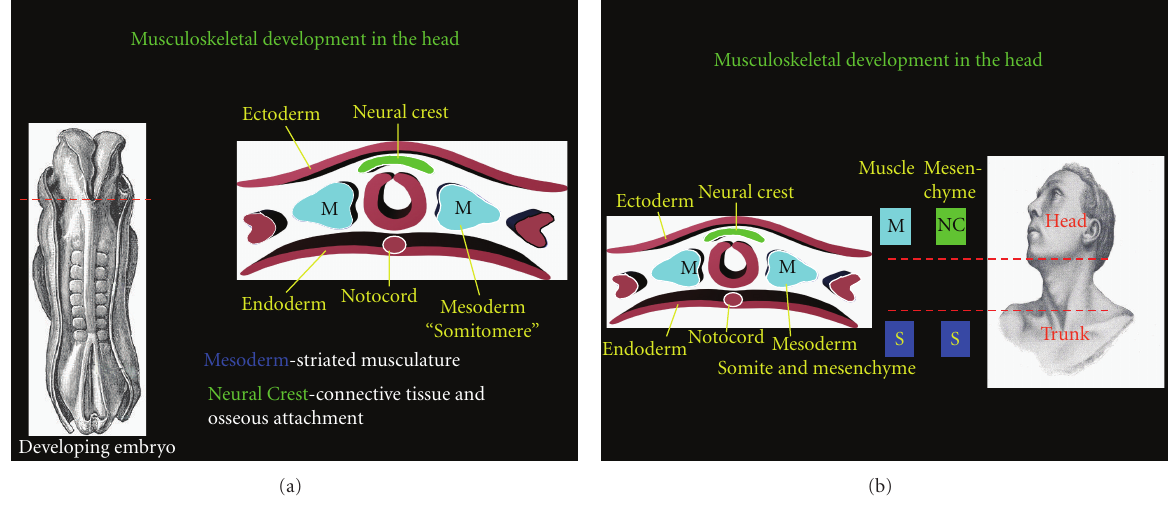
Figure 3: A cross-section through the developing head region shows mesoderm forming somitomeres instead of somites. Somitomeres contribute to the formation of striated muscle in the head, while neural crest cells form the mesenchymal component. A cross-section through the developing embryo head region is seen on the right. In the head, mesoderm does not develop into somites, but remains loosely organized which some authors refer to as “SOMITOMERES”. The mesoderm will still form striated musculature in the head, however; neural crest cells contribute to the connective tissue and the osseous attachment